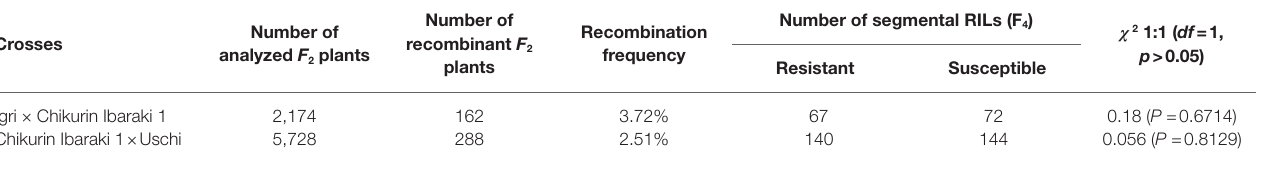
TABLE 1 | Screening of F 2 plants for the construction of rym15 high-resolution mapping populations. Crosses